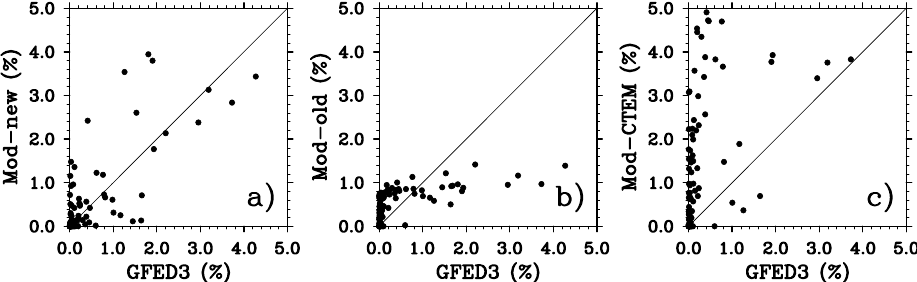
Fig. 10. Comparison of GFED3 and modeled 1997–2004 average annual burned area fraction over Amazon tropical closed forest. The black line depicts the 1 : 1 slope and represents the perfect simulation. Relative mean squared error (MSE divided by the variance of GFED3 annual burned area fraction) is 0.39 for Mod-new, 0.72 for Mod-old and 2.72 for